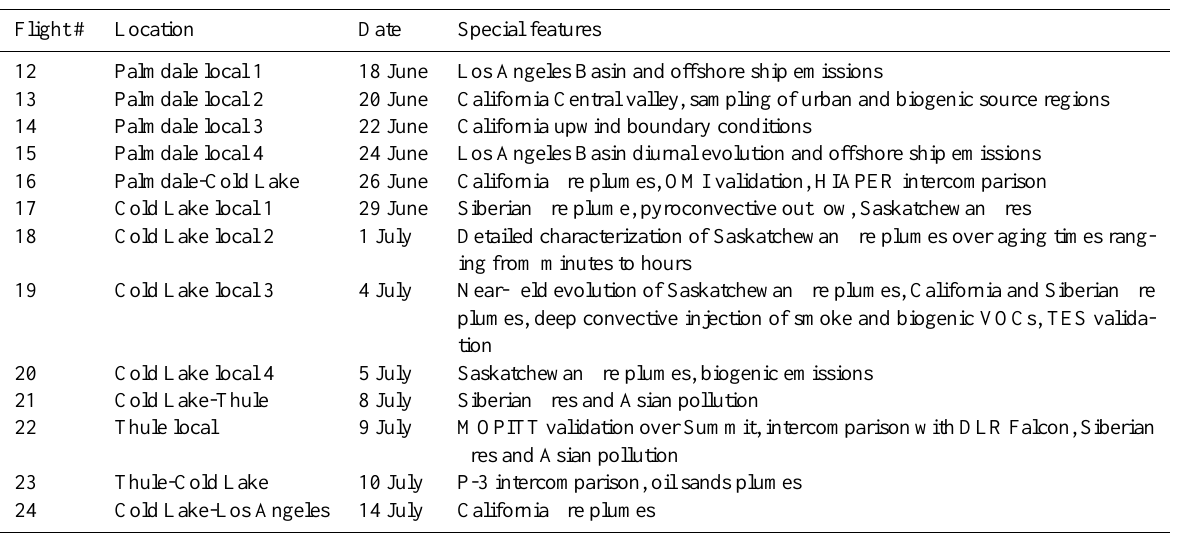
Table 5a. DC-8 flights during the ARCTAS-B summer deployment 1